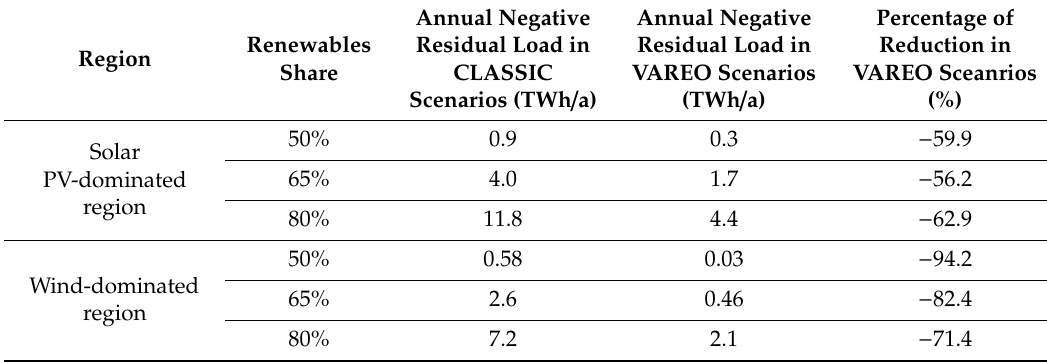
Table 4. Comparison between annual negative residual load of CLASSIC and VAREO scenarios.